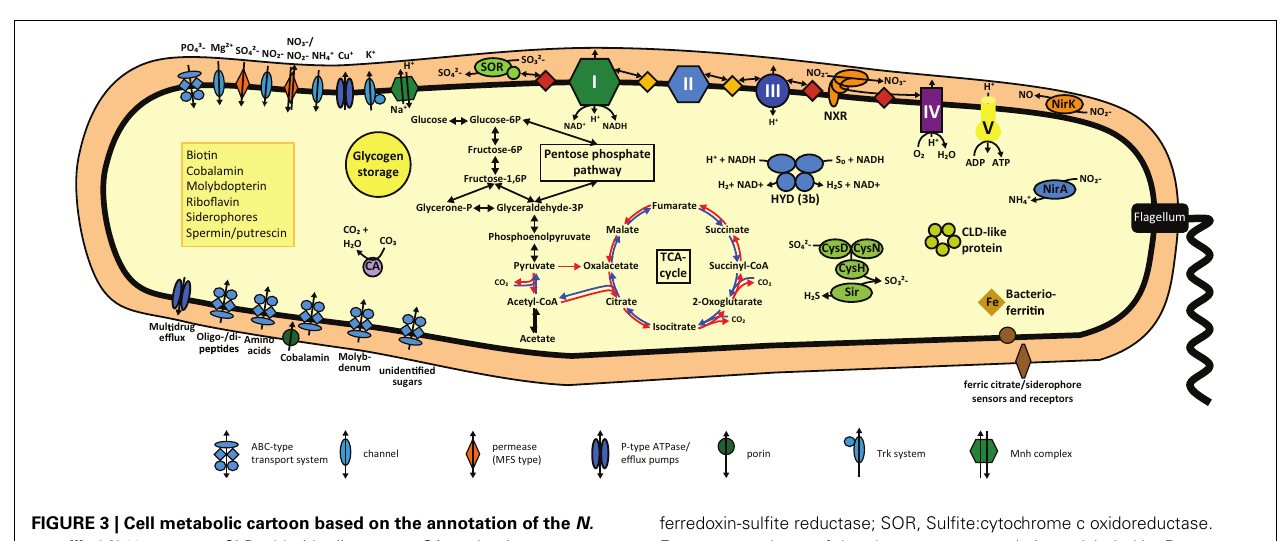
FIGURE 3 | Cell metabolic cartoon based on the annotation of the N. gracilis 3/211 genome. CLD, chloride dismutase; CA, carbonic anhydrase; CysDNC, sulfate adenylyltransferase/adenylylsulfate kinase; HYD, hydrogenase; NirA, ferredoxin-nitrite reductase; NirK, Copper-containing nitrite reductase; NXR, nitrite oxidoreductase; Sir,